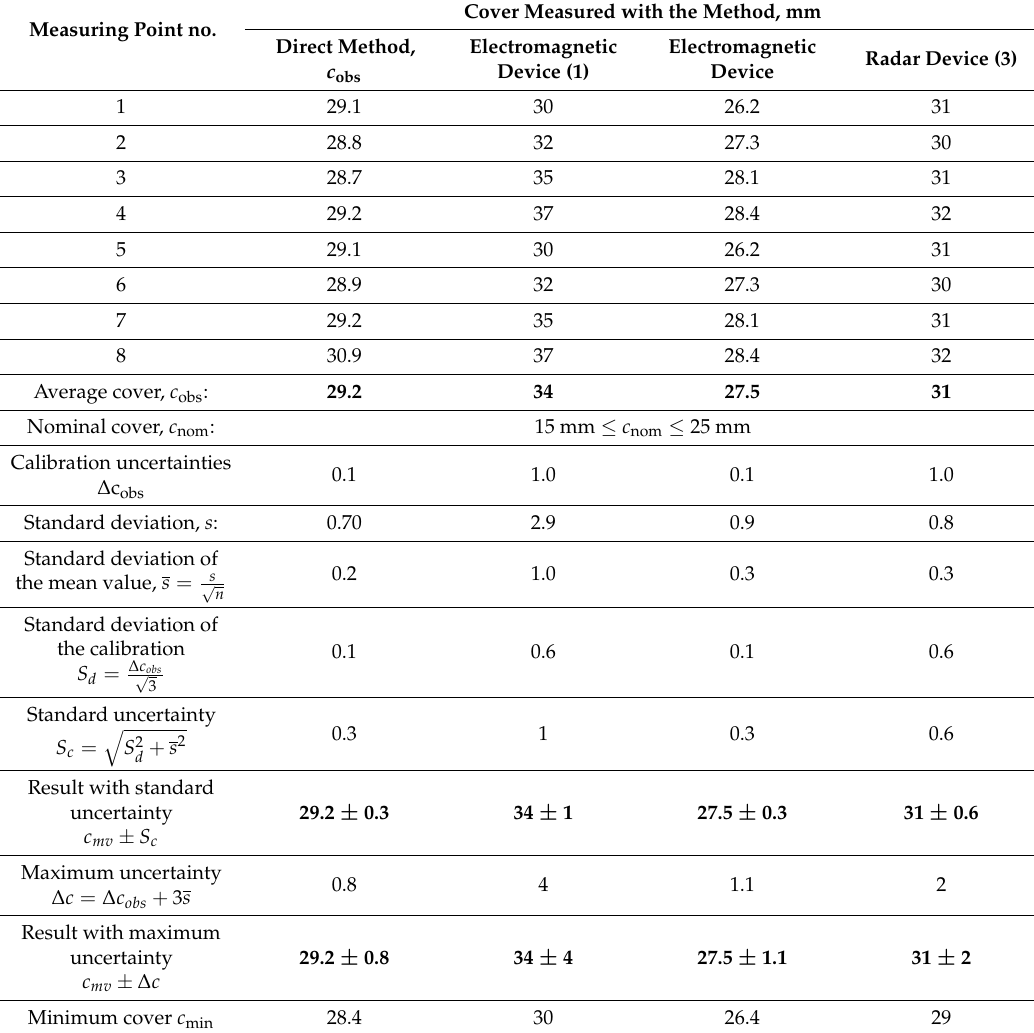
Table 2. Measurement results for the main reinforcement using each